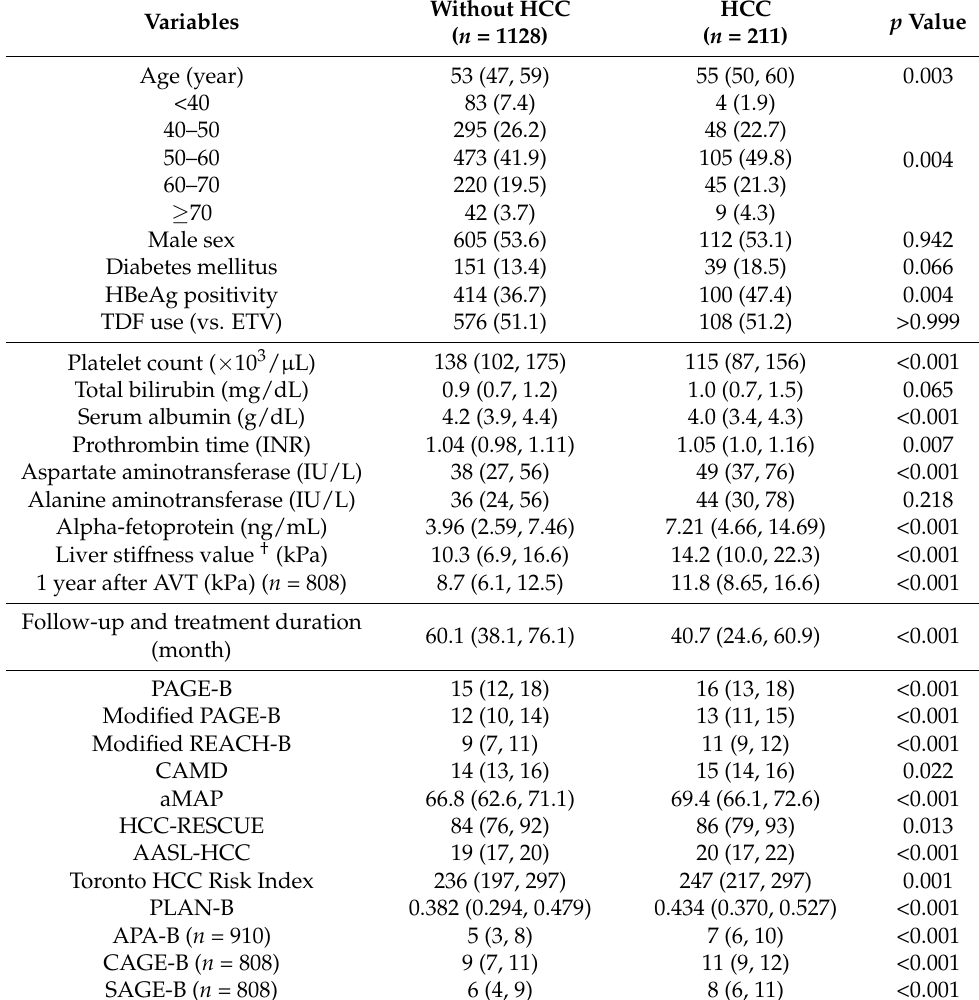
Table 2. Comparison of baseline clinical characteristics between patients with HCC and without.